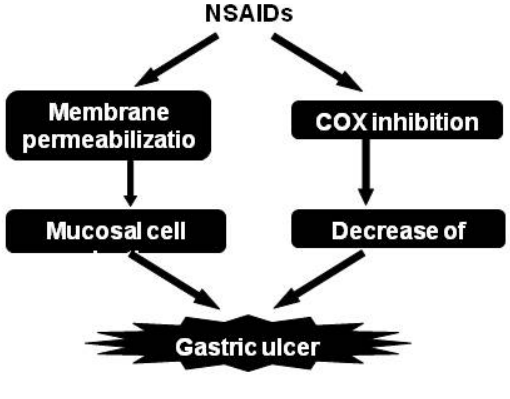
Figure 3. Mechanism for NSAID-induced gastric